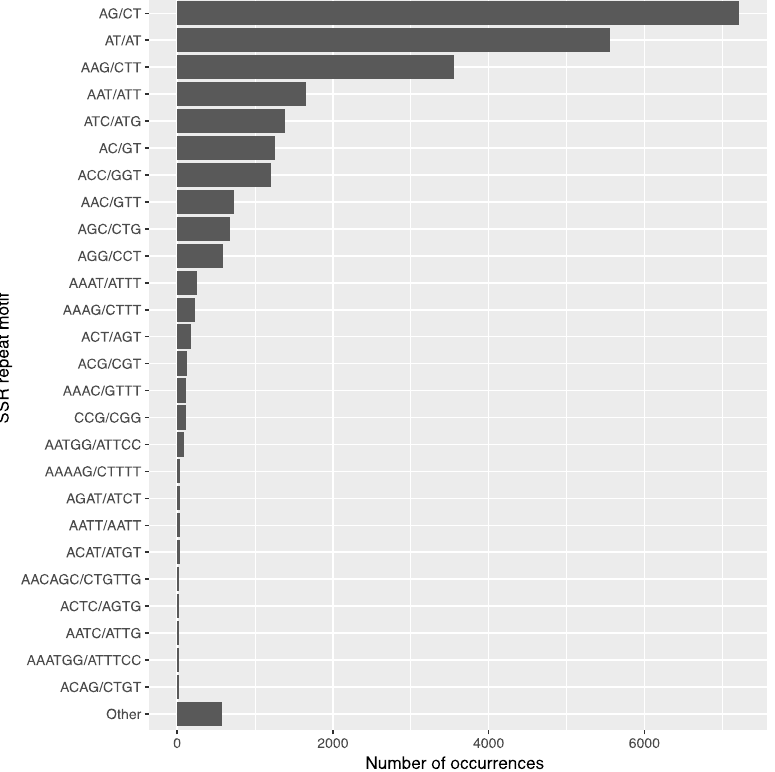
Figure S1: Blobplot of Leaf A, Figure S2: Blobplot of Leaf B, Figure S3: Blobplot of Root A, Figure S4: Blobplot of